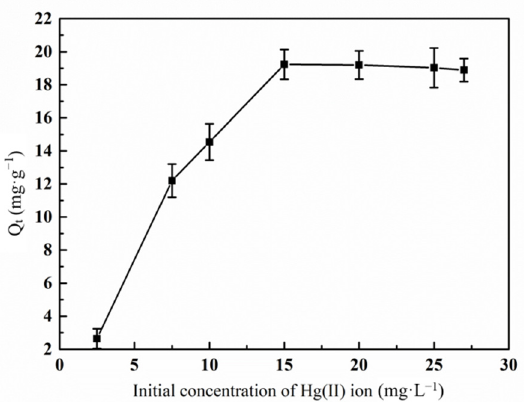
Figure 11. Effect of initial concentration of Hg(II) ion on the adsorption of Hg(II) ions by graft polymer (contact time 120 min; pH value 5.5; treatment temperature 45 °C).